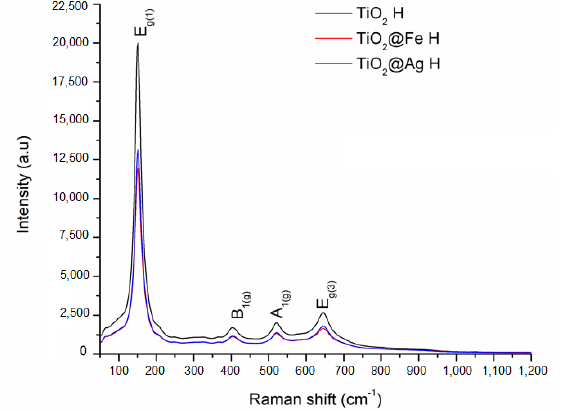
Figure 6. Raman analysis corresponding to the samples obtained by the microwave-assisted hydrothermal (H) method.